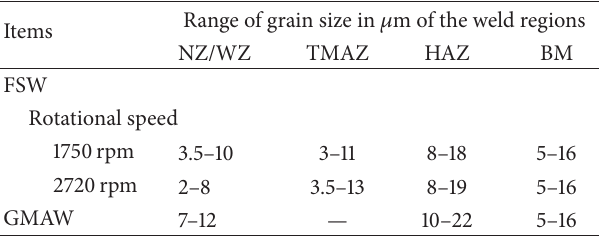
Table 1: Grain size at different welding zones for FSW and GMAW for Al-Al